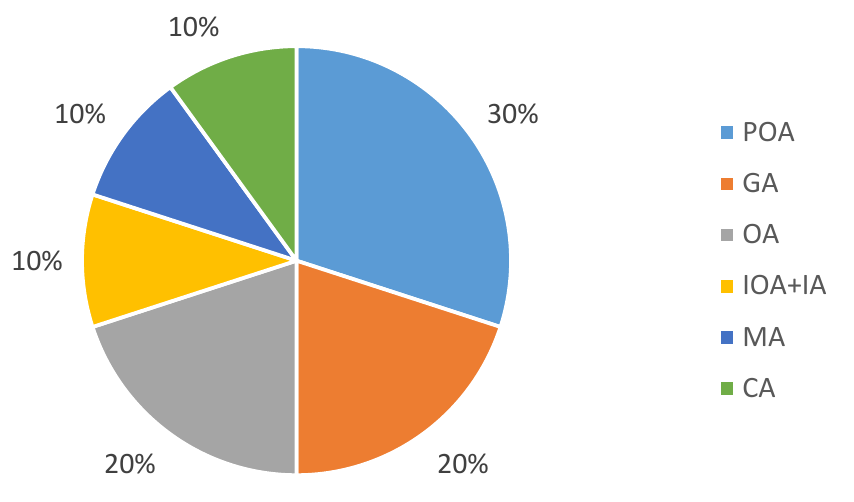
Figure 4. Distribution of input approaches used